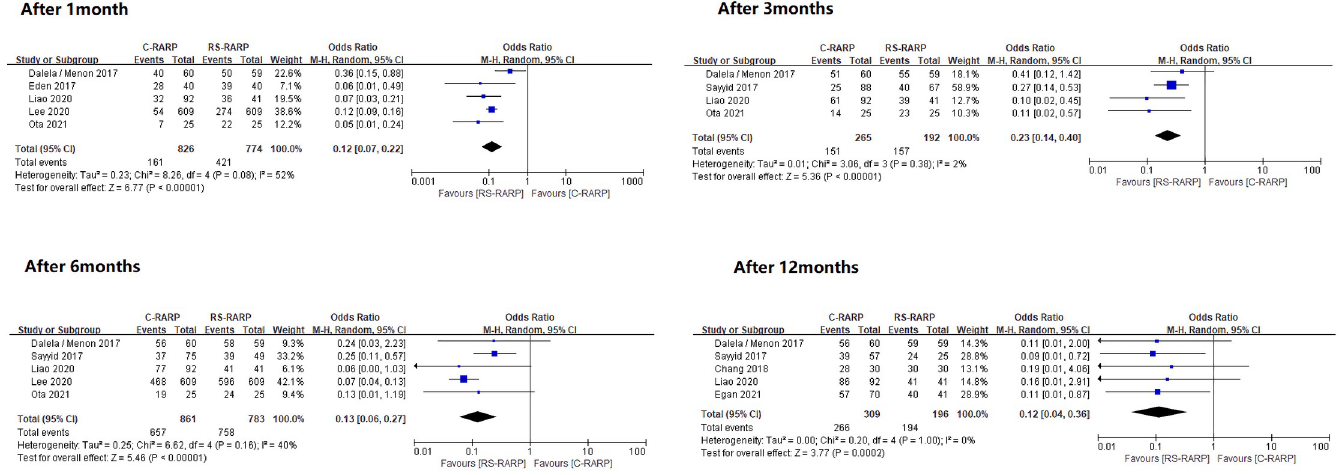
Fig 3. Forest plots of recovery of continence after surgery_safety pad definition.